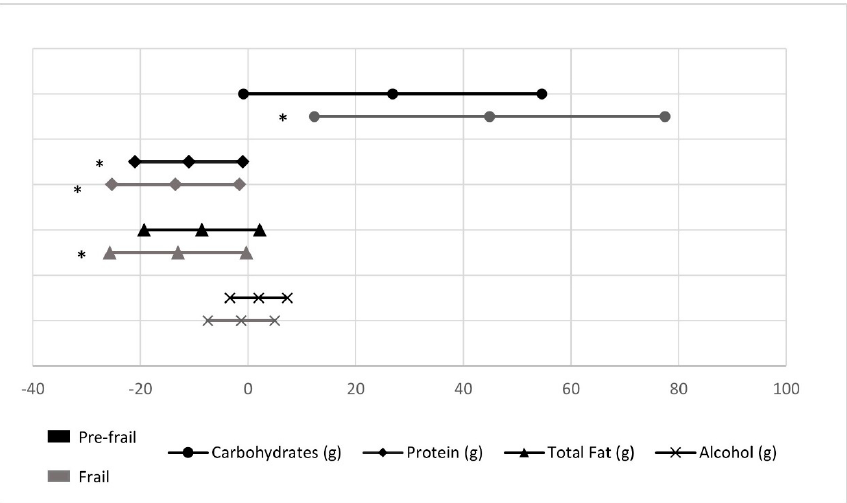
Figure 1. Macronutrient and alcohol intake in pre-frail and frail groups compared with robust (reference group). * Statistically significant differences ( p value < 0.05). Data illustrating fat-type consumption are presented in Figure 2.